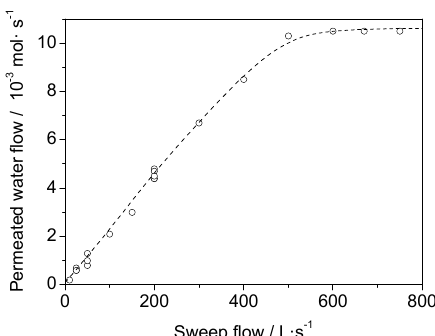
Figure 6. Water flux permeated through a Nafion tube (0.0086” ID, 0.012” thickness) under liquid-vapor permeation (LVP) conditions at room temperature using a dry N 2 sweep flow in an external shield formed by a PTFE tube of ¼” OD.